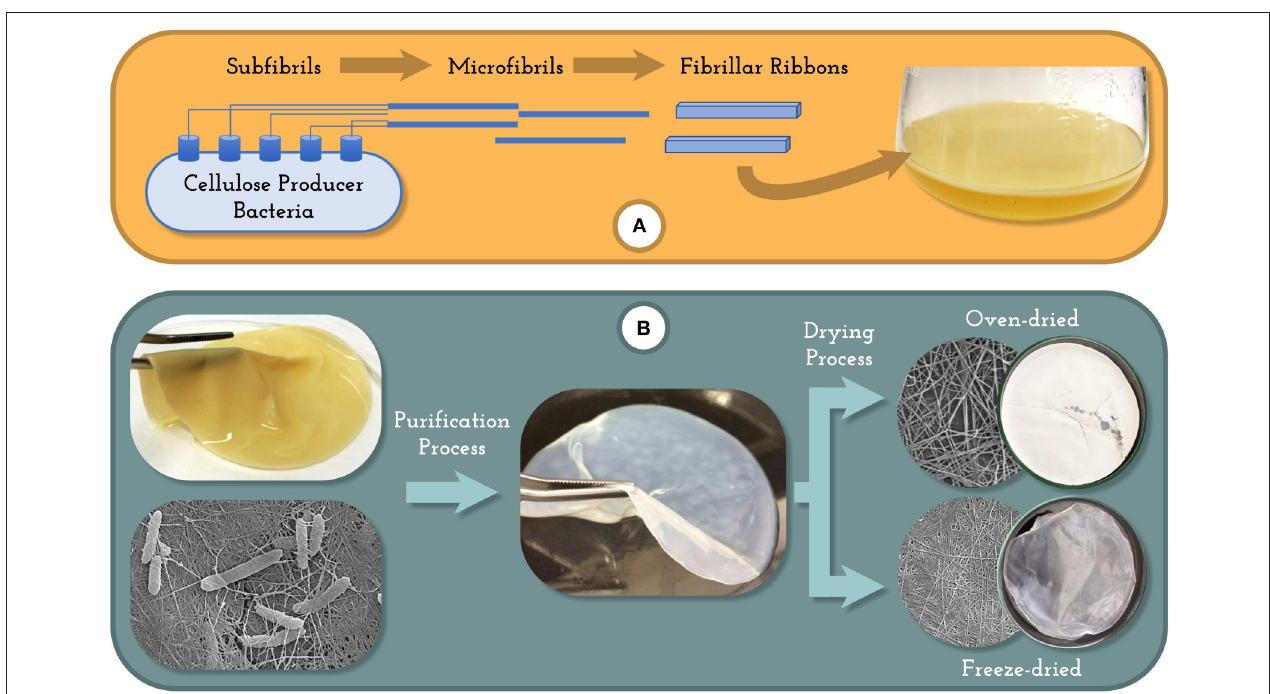
FIGURE 1 | Biosynthesis (A) and downstream processing (B) of bacterial